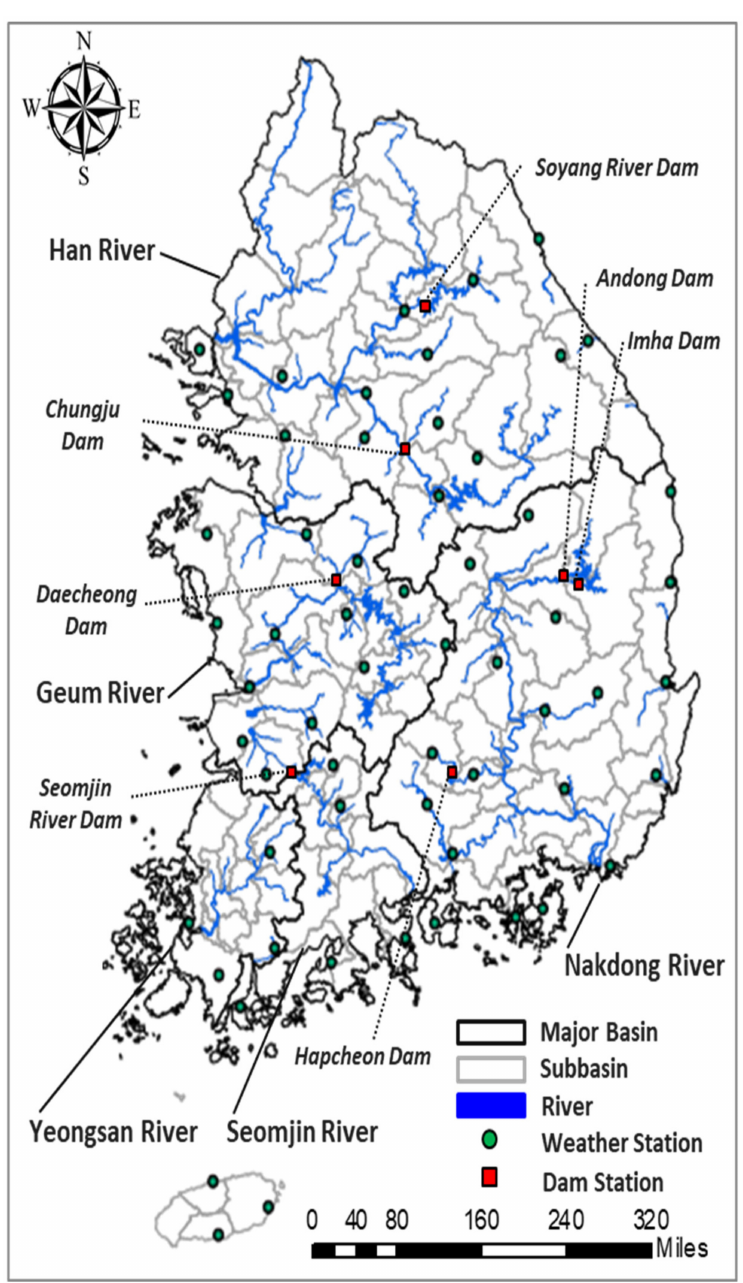
Figure 1. Study area and weather station and multipurpose dam